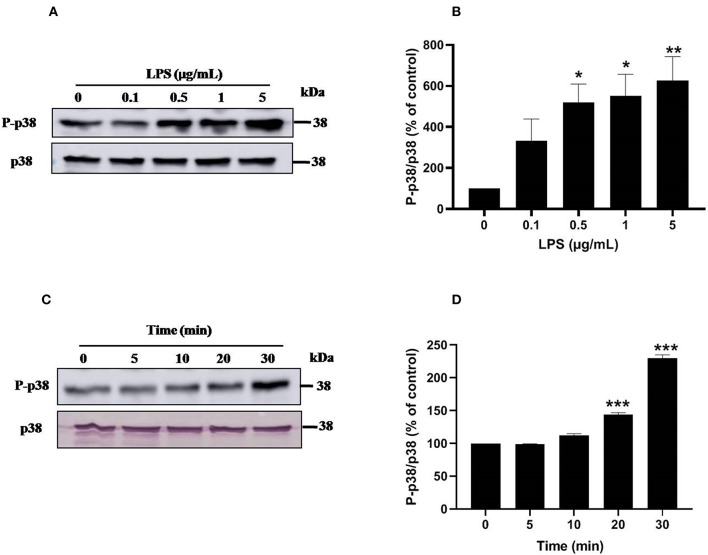
LPS induces p38 MAPK activation in human neutrophils. (A) Neutrophils (10 × 106 cells/mL) were incubated with various concentration of LPS (0, 0.1, 0.5, 1, 5 μg/mL) for 20 min at 37°C. Cells were analyzed by SDS-PAGE and western blot using anti-phospho-p38 and anti-p38 antibodies. (B) Western blots from different experiments were scanned and quantified, total p38 were quantified by densitometry, and the intensity of phosphorylated p38 was corrected for the protein amount of p38. (C) Neutrophils (10 × 106 cells/mL) were incubated with LPS (1 μg/mL) for indicated times (0, 5, 10, 20, 30 min). Cells were analyzed by SDS-PAGE and immunoblotting with anti-phospho-p38 and anti-p38 antibodies. (D) Western blots from different experiments for the kinetic effect were scanned and quantified, total p38 were quantified by densitometry, and the intensity of phosphorylated p38 was corrected for the protein amount of p38. Data are mean ± SEM of three or more separate experiments. p < 0.005 as compared to control (100%). *p < 0.05, **p < 0.01 and ***p < 0.001.